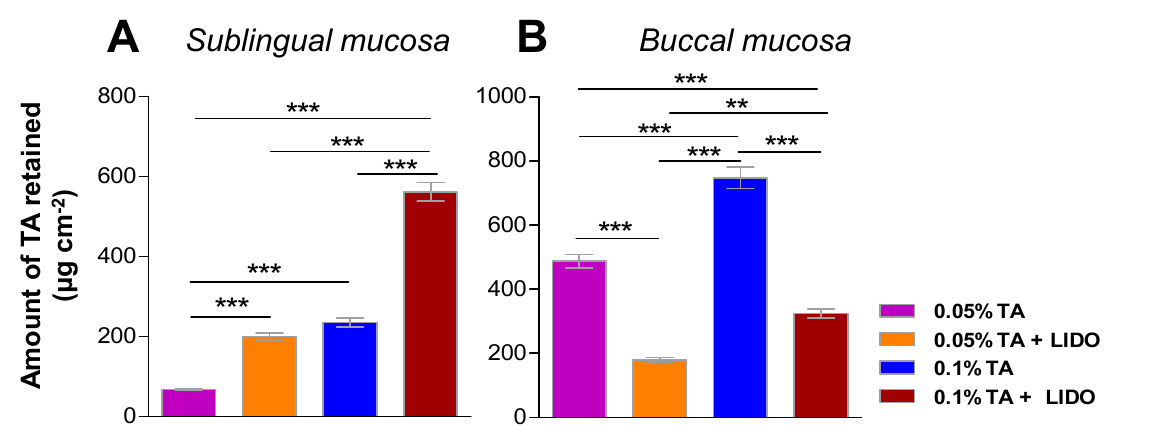
Figure 9. Amount of TA retained in ( A ) sublingual or ( B ) buccal mucosa 8 h after application of the formulation in dynamic conditions. Values represent Means ± SD ( n = 5). Significant differences: ** ( p < 0.01) *** ( p < 0.001).